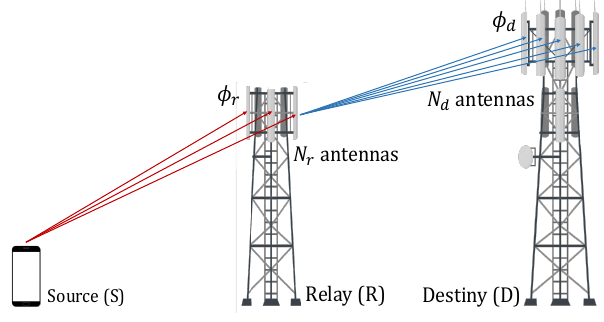
Figure 1. DF-EGC dual-hop relay system